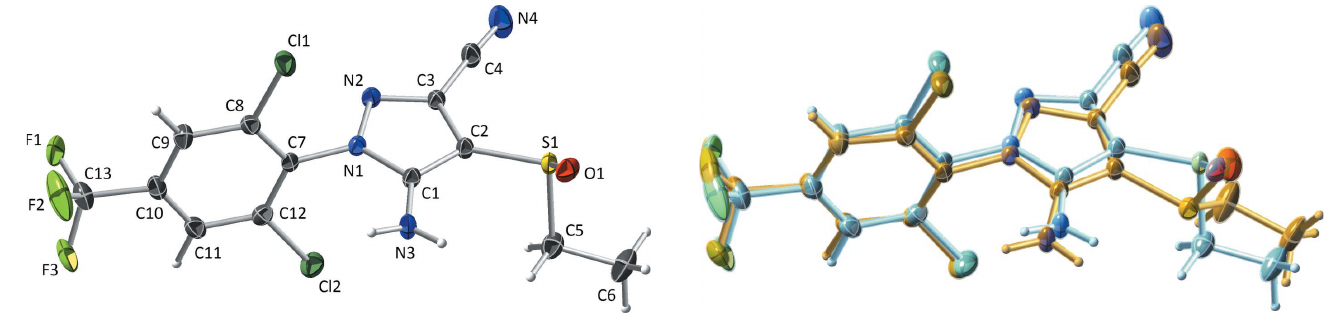
Figure 1 An ellipsoid plot (50% probability) of the major disorder component in crystals of ethiprole. Hydrogen atoms are drawn as spheres of arbitrary